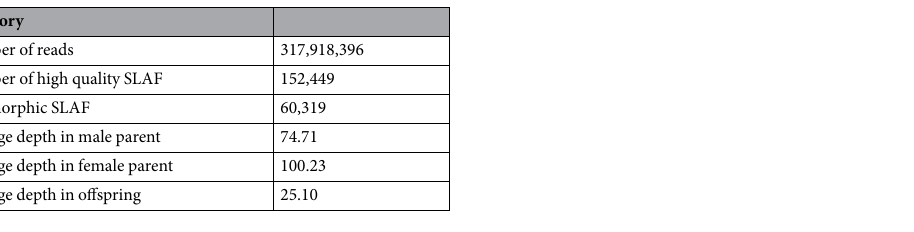
Table 3. Statistics of the SLAF data.